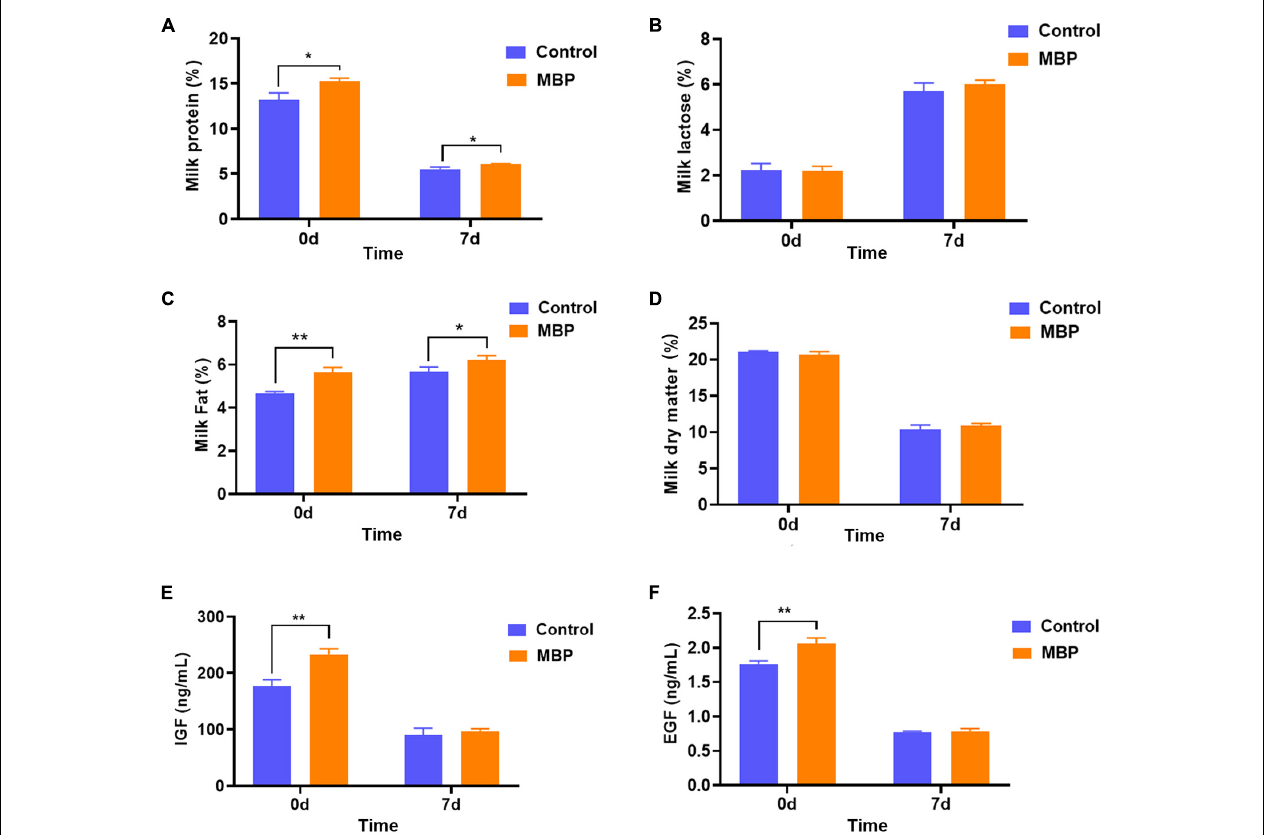
FIGURE 3 | Effects of MBP on nutritional composition and growth factors in the colostrum and transitional milk (day 7) of sows. (A) Protein content. (B) Lactose content. (C) Fat content. (D) Dry matter content. (E) Concentration of IGF. (F) Concentration of EGF. Data represent mean ± SD. * p < 0.05, ** p < 0.01 versus